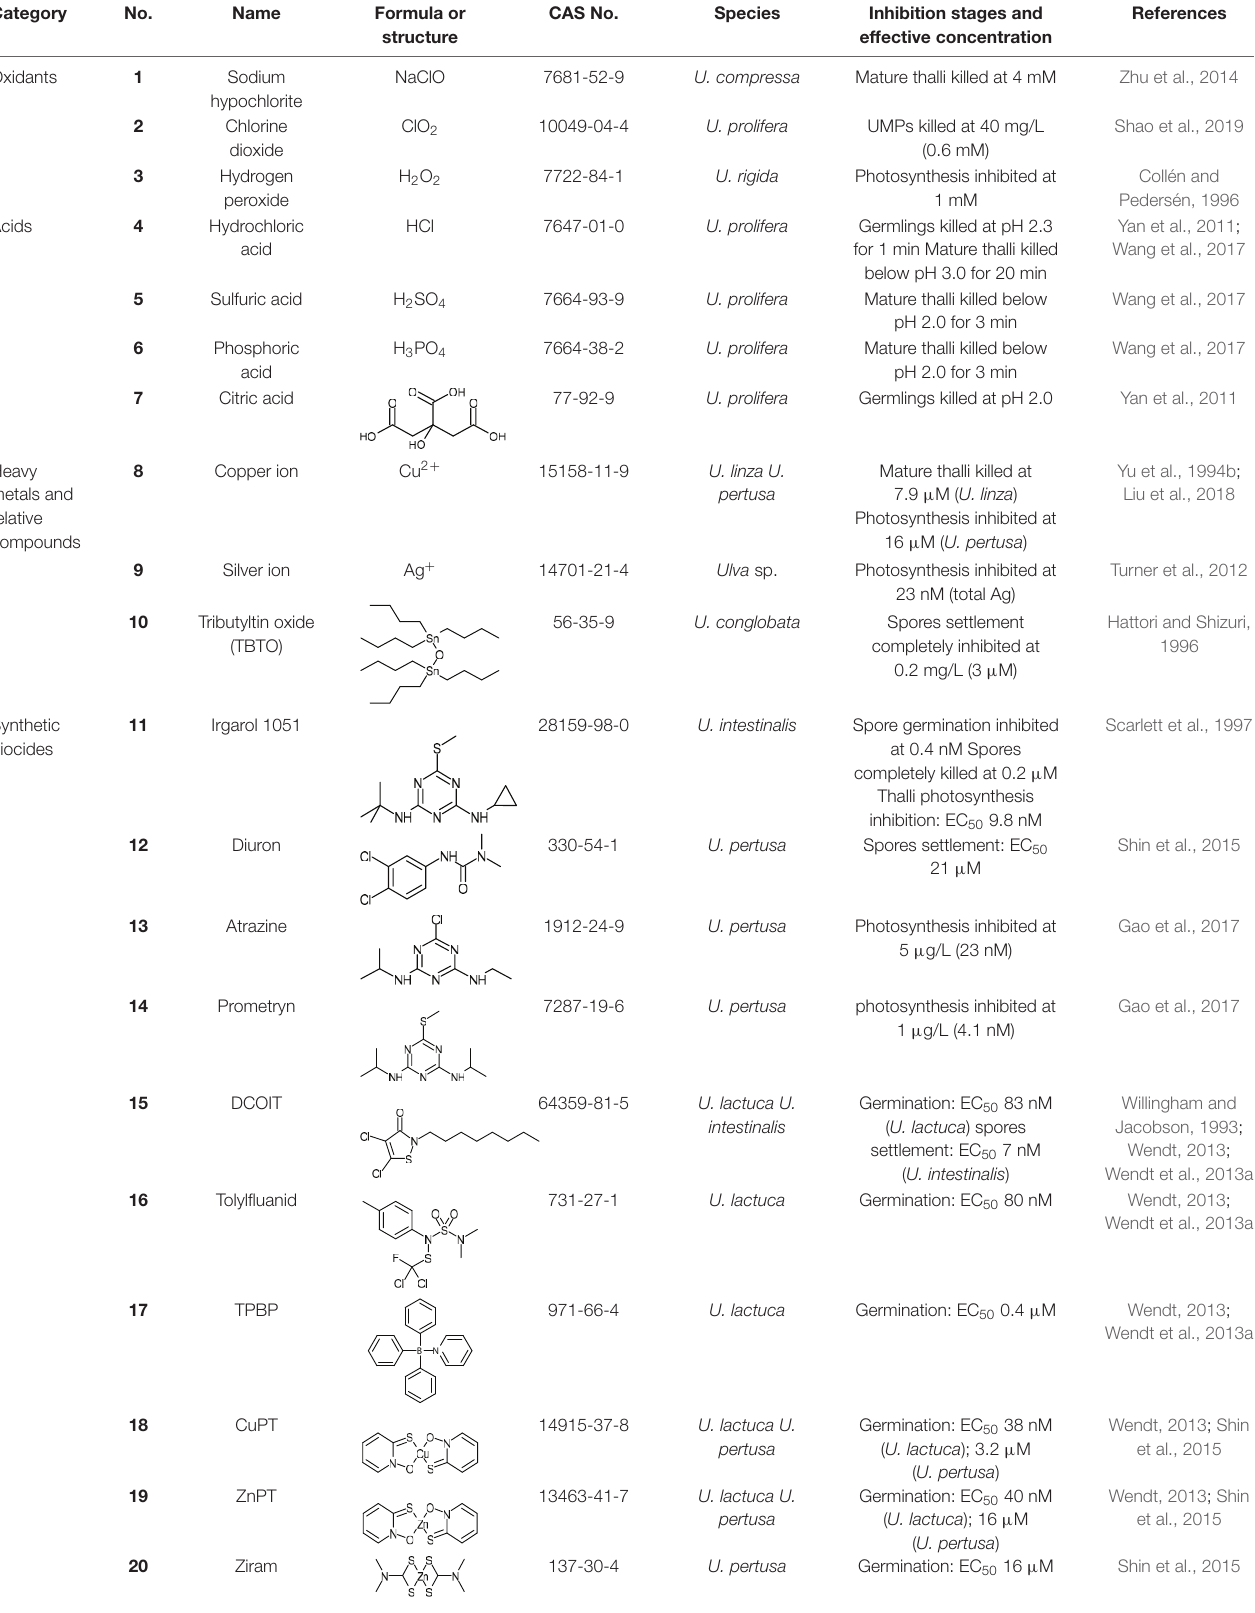
TABLE 3 | Key agents in classical chemical methods and their anti-algal abilities against Ulva . Category